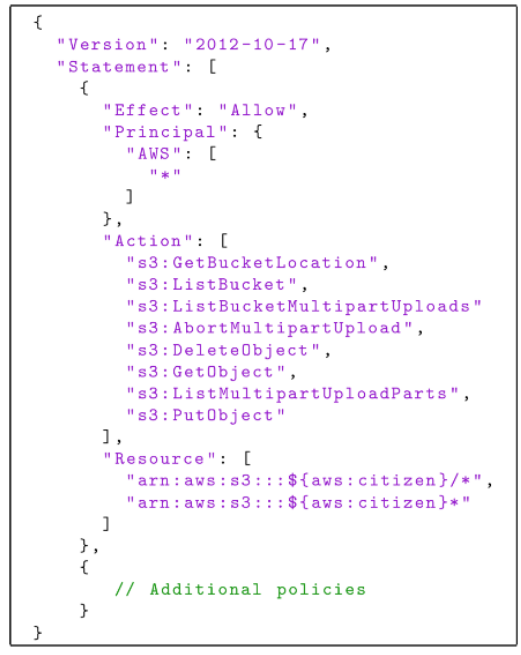
Figure 5. Sample policy for citizen’s account on the cloud.